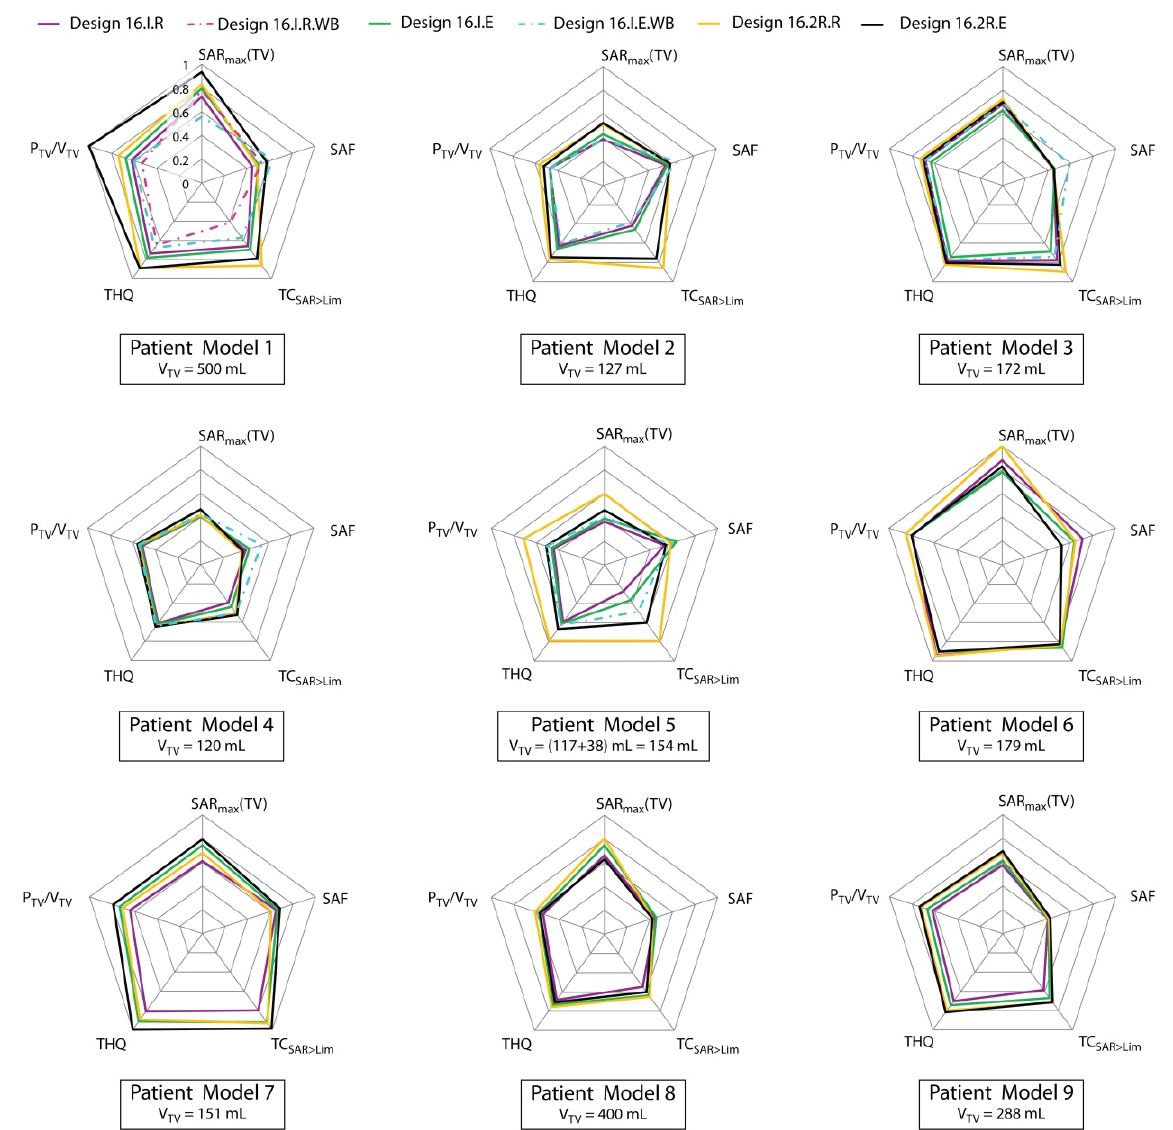
Figure 6. Comparison of the 16 channel interleaved and two row arrays (16.I.* and 16.2R.*) for all patient models. For better comparability, all metrics were normalized to their overall maximum. Purple: 16.I.R; magenta (dashed): 16.I.R.WB; green: 16.I.E; cyan (dashed): 16.I.E.WB; yellow: 16.2R.R; black: 16.2R.E.